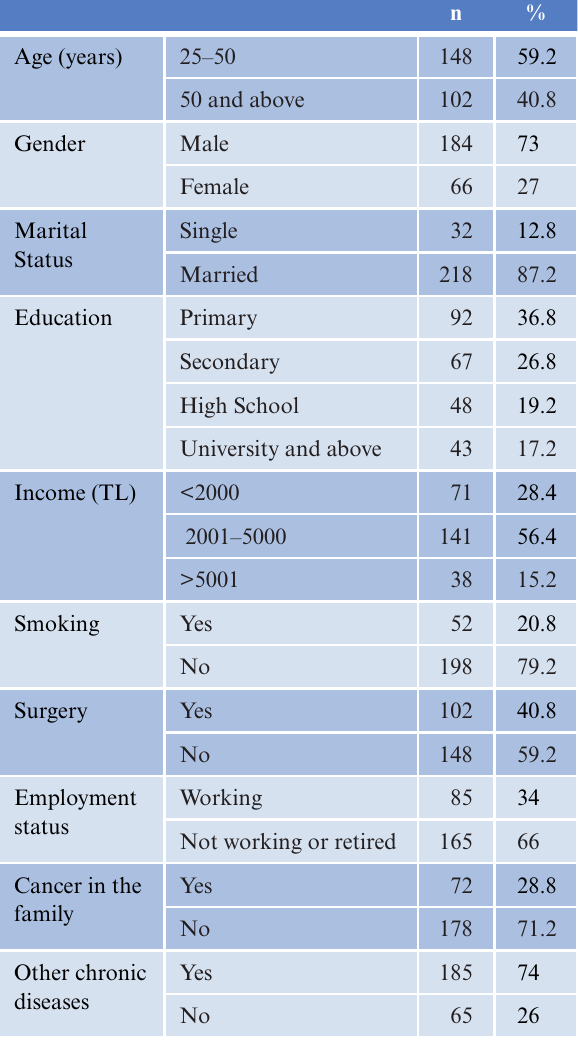
Table 1: Socio-demographic characteristics of participants ( n = 250).